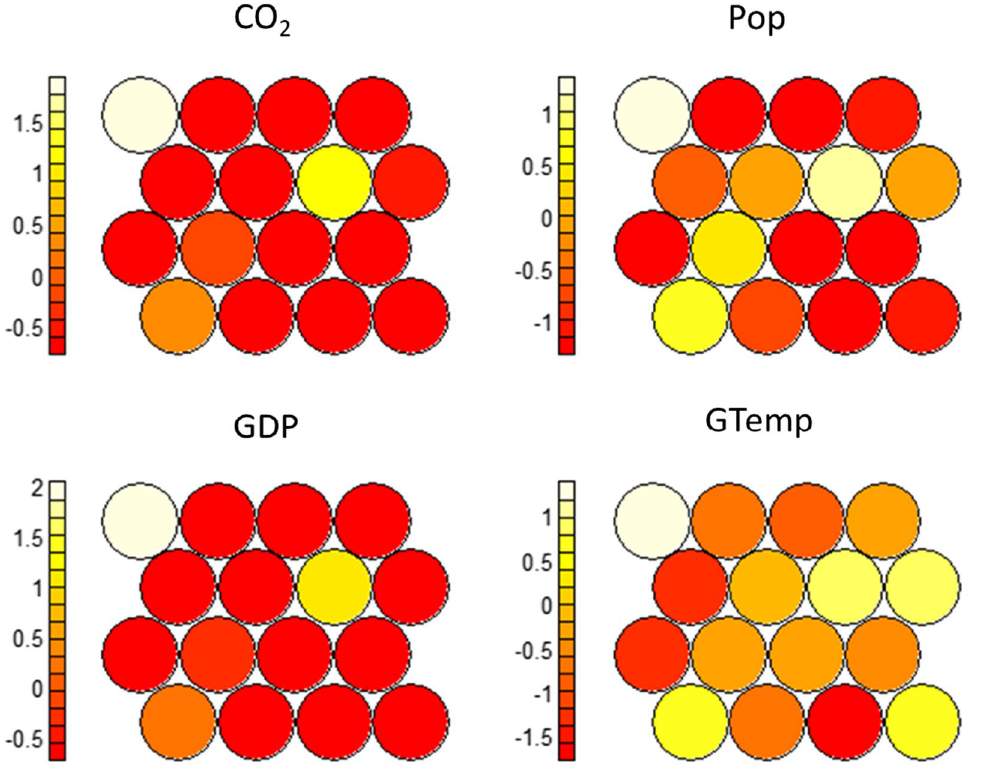
Fig. 5 Self‑organizing component maps